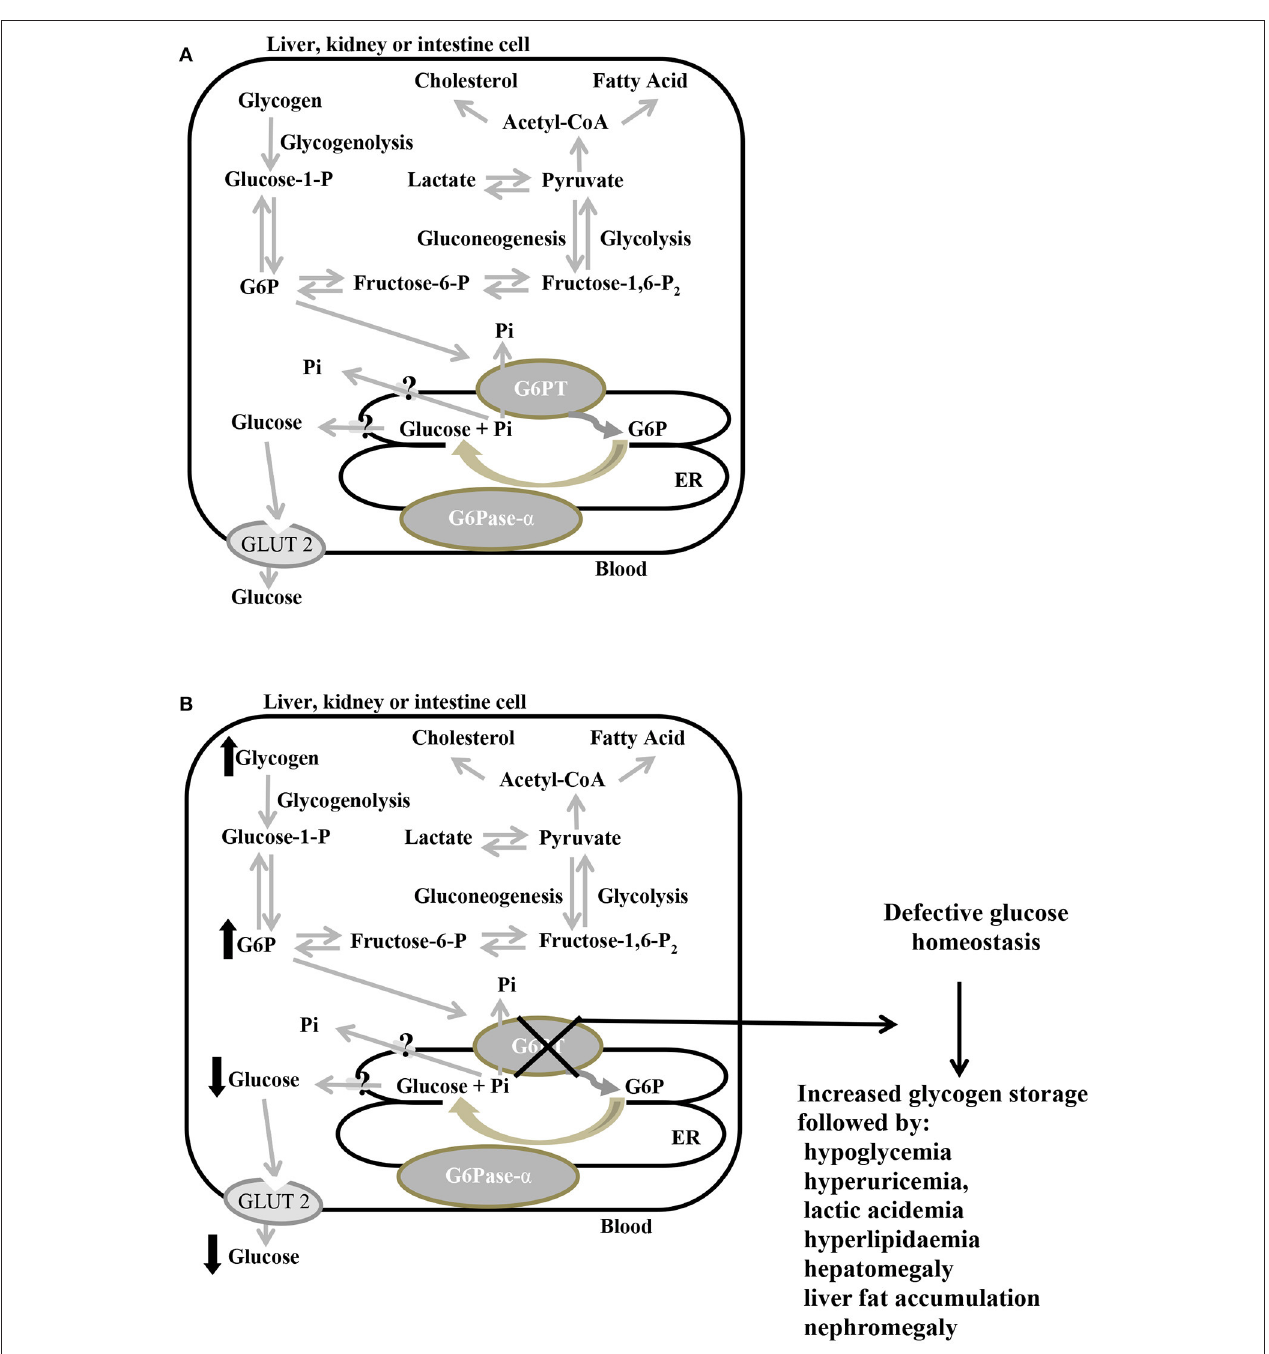
FIGURE 3 | Primary metabolic pathways of G6P in the liver, kidney, and intestine, in normal (A) and defective G6PT (B) cells. Schematic cell harboring an extended endoplasmic reticulum (ER). G6Pase- α and G6PT are embedded in the ER membrane; the glucose transporter GLUT2 is embedded in the plasma membrane. Black arrows indicate metabolic changes due to defective SLC37A4. G6P, glucose-6-phosphate; G6Pase- α , glucose-6-phosphatase- α ; G6PT, glucose-6-phosphate translocase; GLUT2, glucose transporter 2; P, phosphate; Pi, inorganic phosphate.